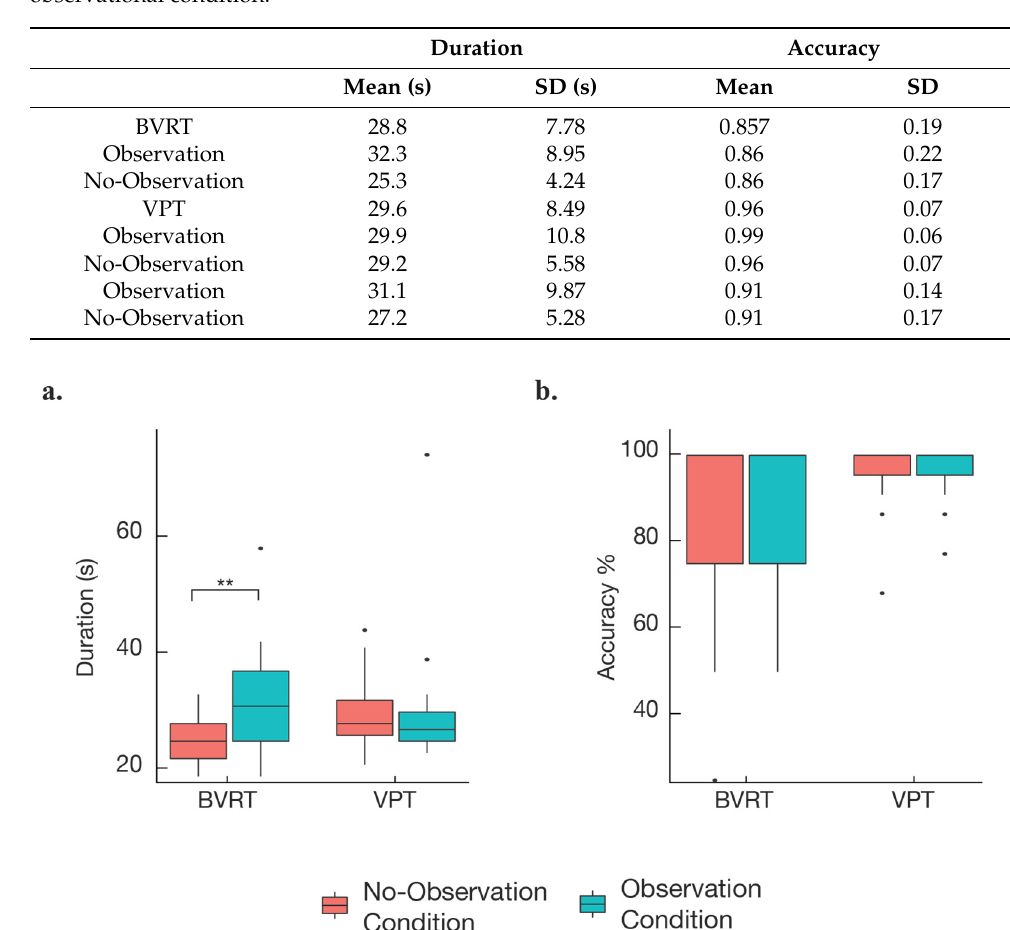
Table 1. Summary of behavioral data with means and standard deviations of task duration and accuracy for each of the two experimental conditions as well as by task format condition and obser- vational condition.